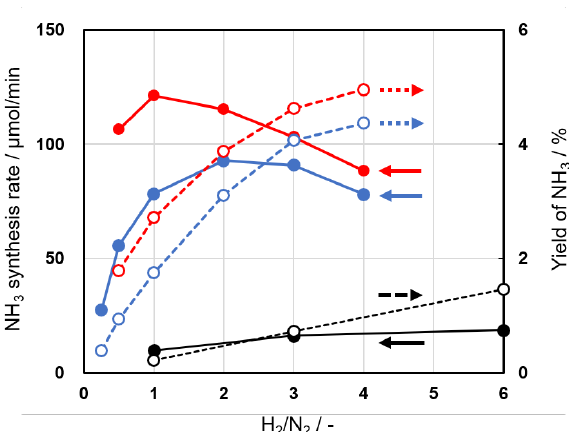
Figure 7. Change in the synthesis rate (closed) and yield (open) of ammonia as a function of the N 2 / H 2 ratio using Al 2 O 3 (SC) (blue) and 5Ni/Al 2 O 3 (KC, 773) (red) catalysts. The results of the blank experiment (black) are also shown for comparison. Reaction conditions: applied voltage, 6 kV; frequency, 50 kHz; electrode length, 150 mm; total flow rate, and 100 mL min −1 .